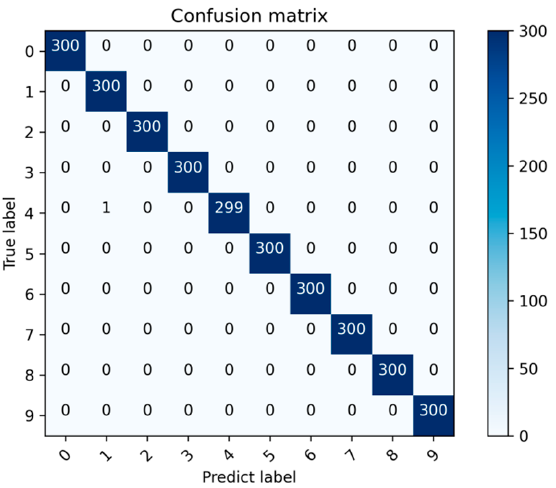
Figure 9. Confusion matrix of the SR-1DCNN model (test set of CWRU).